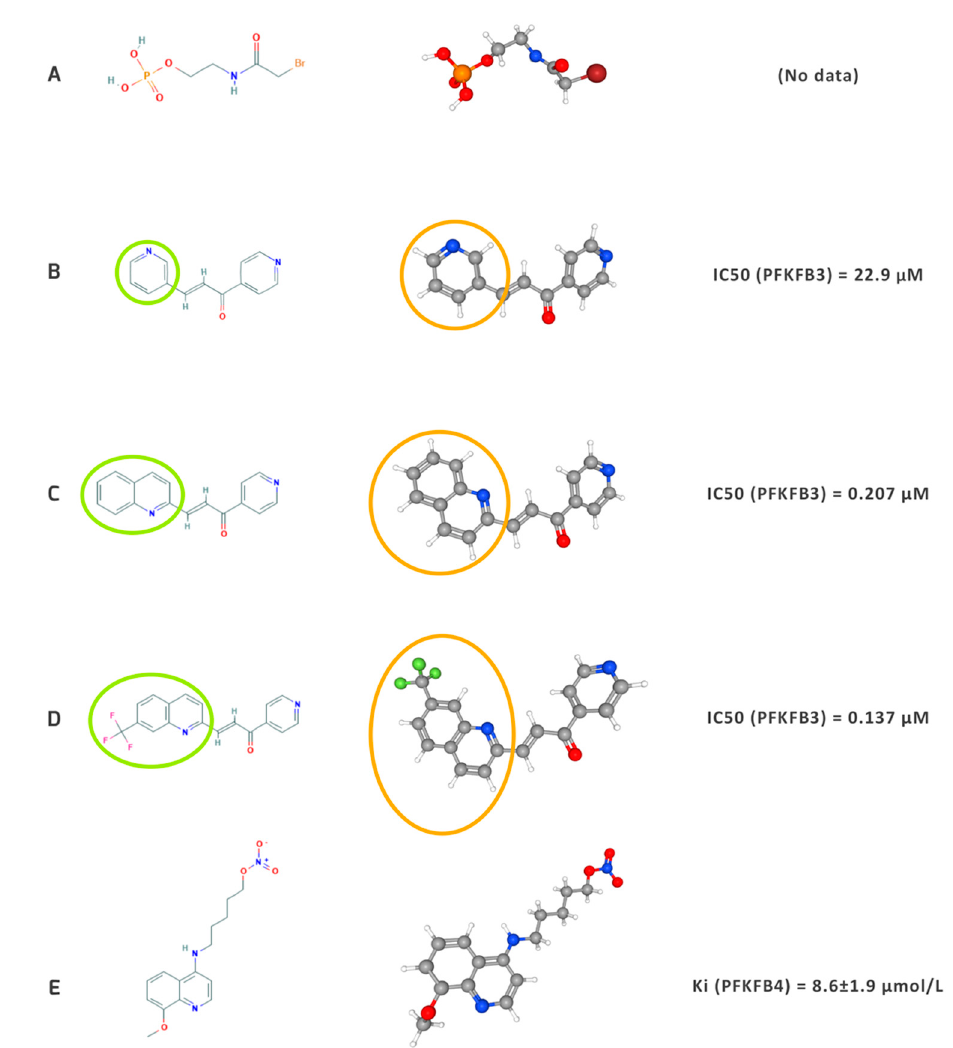
Figure 10. Structural models (on the left), 3D models (in the middle) and IC50 or Ki values of the most important PFKFB3 ( A – D ) and PFKFB4 ( E ) inhibitors to date. The models were obtained from PubChem: ( A )—N-Bromoacetylethanolamine phosphate [154], ( B )—3-(3-pyridinyl)-1-(4-pyridinyl)-2-propen-1-one (3PO) [155], ( C )—PFK15 [156], ( D )—PFK158 [157], ( E )—5MPN [158]. The circles illustrate the differences in the chemical (green circles) and 3D structure (orange circles) between the 3PO ( B ), PFK15 ( C ), and PFKF158 ( D )–consecutive derivatives chalcone compounds. IC50 and Ki values were obtained from Wang et al. (2020) [4] and Chesney et al. (2015)